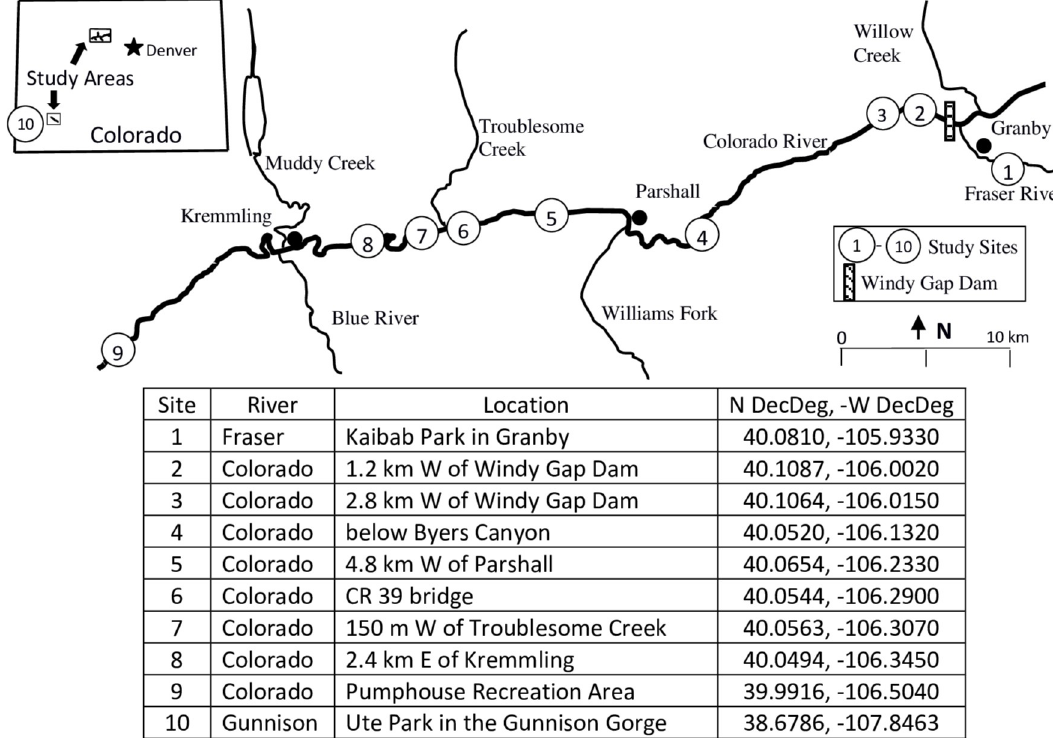
Fig 1. Benthic and exuvia collection sites of Pteronarcys californica in 2010 from the Colorado and Fraser Rivers. Gunnison River site shown only on inset map.